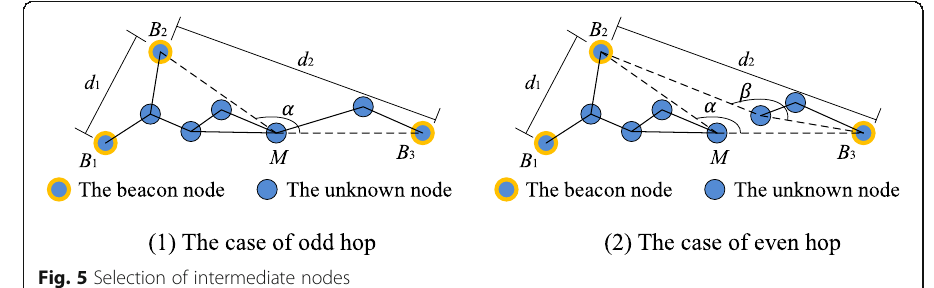
Fig. 5 Selection of intermediate nodes